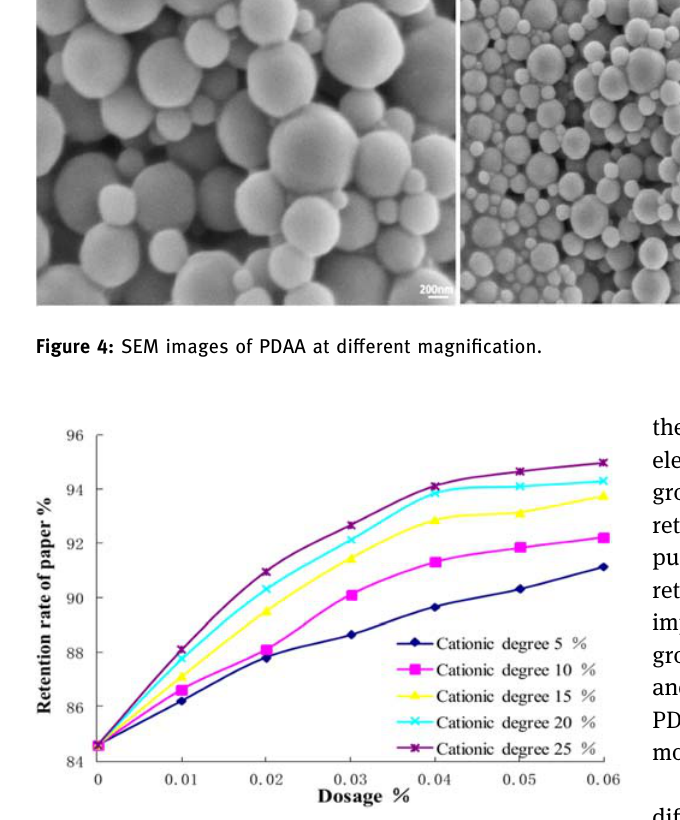
Figure 5: E ff ect of cationic degree on retention properties. The molecular weight of PDAA is 3